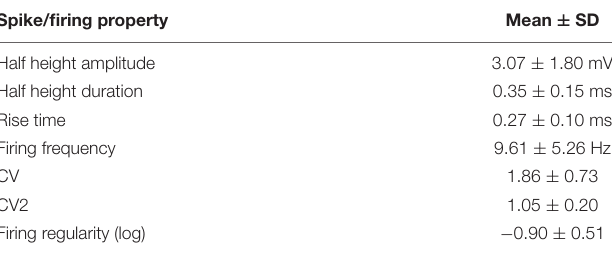
TABLE 1 | Population data of spike shape and spike firing